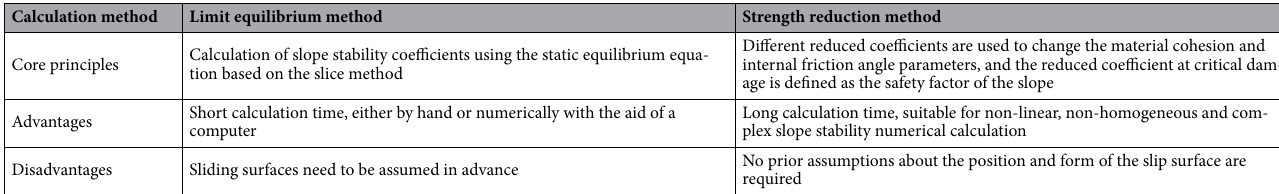
Table 1. Comparative analysis of the advantages and disadvantages of two typical slope stability calculation methods 21–23